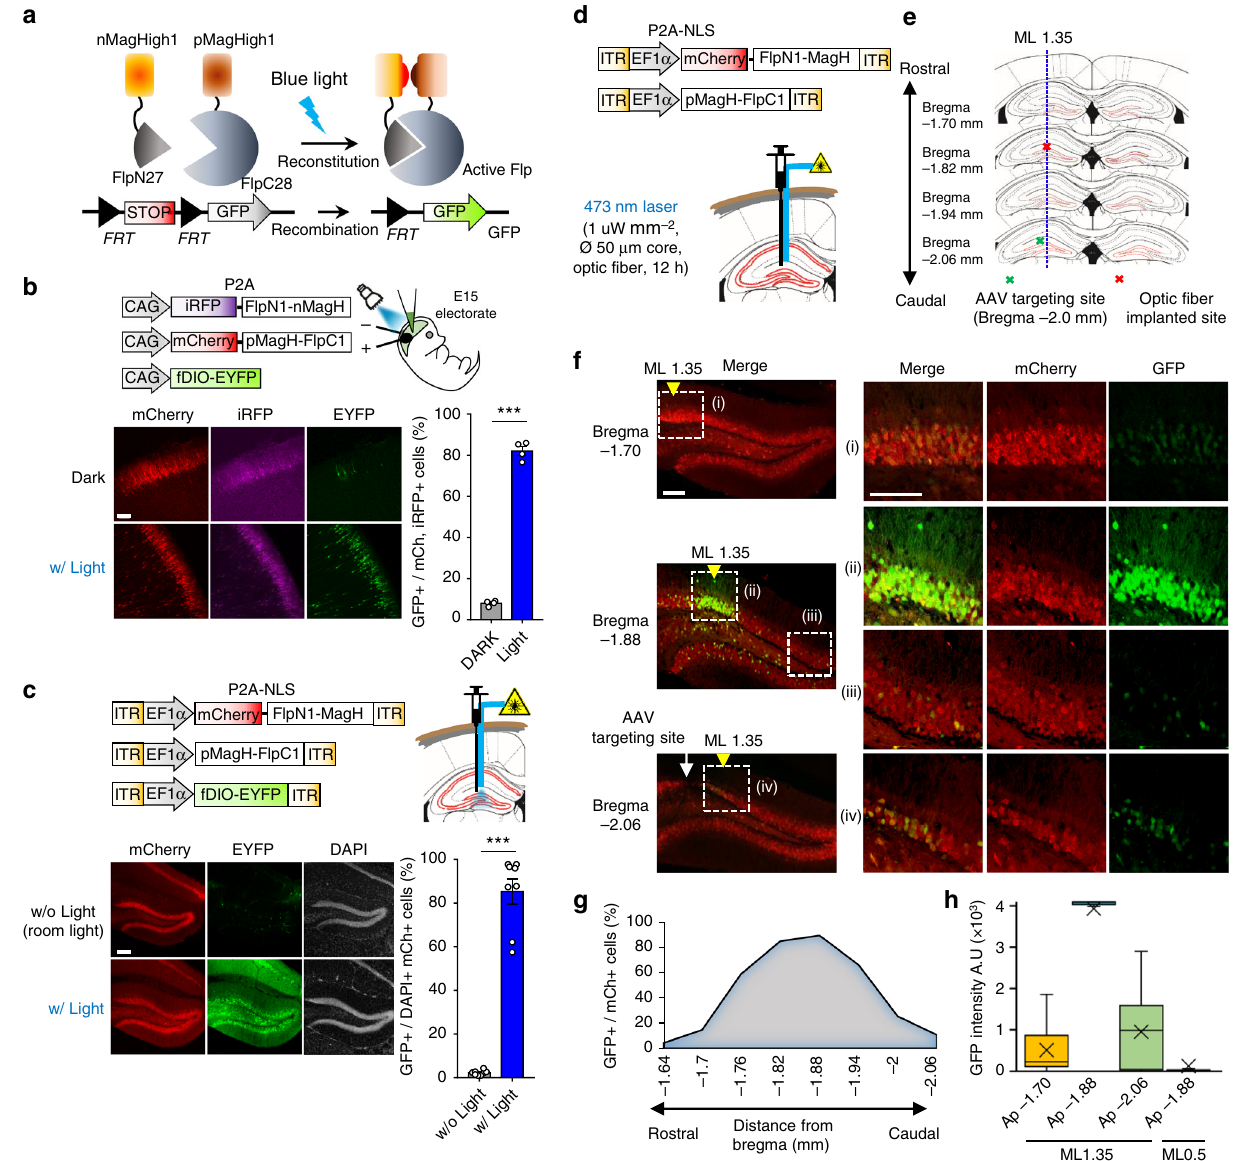
Fig. 1 Development of PA-Flp. a Schematic depicting PA-Flp reconstitution and activation upon blue light illumination, and detection of GFP signals by PA- Flp-mediated deletion of a stop cassette in a Frt- fl oxed construct. b PA-Flp and fDIO-YFP (Flp reporter) expression plasmids were electroporated into an embryonic mouse brain (E15), with (w/) subsequent noninvasive light stimulation (0.5 mW mm − 2 , blue fl uorescent gun) at postnatal day 1 – 2 (P1 – 2) or maintained in dark conditions. Pup brains were harvested at P3-4. c AAV-EF1a-PA-Flp and AAV-EF1a-fDIO-YFP were co-infected into the hippocampus of 8-wk-old mice, with 30 min light (0.4 mW mm − 2 , 20 Hz, 20% duty cycle) or without (w/o) light stimulation 2 wks after infection and sacri fi ced 1 wk after light stimulation. A blue line indicates laser light path through implanted optic fi ber. b , c Measurement of GFP positive cells among both mCherry and iRFP positive (GFP + /mCh + iRFP + ) cells or among both DAPI and mCherry positive (GFP + /DAPI + mCh + ) cells in 4 – 8 coronal slices at each group. Scale bar: 100 μ m. Data represent means ± s.e.m. ( n = 2 mice/group; *** P < 0.0001, two-tailed Student ’ s t -test). d , e Schematic depicting AAV infection in the mouse hippocampus and local light stimulation via implanted optic fi ber ( d ), and AAV targeting sites (green) and optic fi ber implantation sites (red) ( e ), in coronal sections of hippocampus. f Left: representative images showing local labeling of GFP signals from RCE:FRT mice at different depths along the rostral-caudal (RC) axis. Yellow arrowhead indicates the medial-lateral (ML) 1.35 coordinate. Right: sites (i) – (iv) at left marked in white-dashed squares are shown in higher-magni fi cation views in the correspondingly labeled rows. Sites (i), (ii), and (iv) indicate the same ML coordinate along the RC axis; (iii) indicates a distal site with a different ML coordinate on the same coronal section of bregma ( − 1.88 mm). Scale bar: 100 μ m. g , h Analysis of percentage ( g ) and intensity ( h ) of GFP signals along the ML axis at the same RC coordinate (bregma − 1.88 mm) or RC axis on the same ML coordinate (ML 1.35). Measurement performed in each coronal slice. Data represent means ± s.e.m. ( n = 1